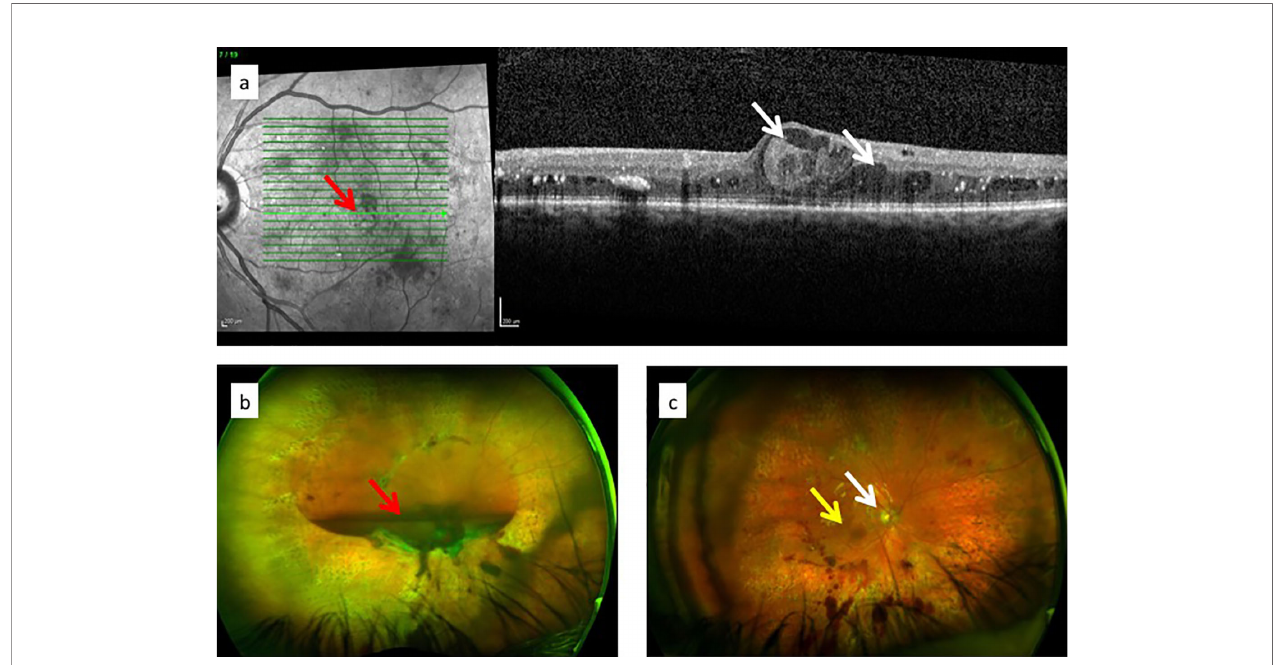
FIGURE 6 | (a) Optical coherence tomography (OCT) images of diabetic macular oedema: fundus image to indicate plane of “ optical section ” (red arrow) through the retina showing macular oedema/retinal cysts (white arrows) in image on the right; (c) ultrawide angle, pre-surgical image of pre-retinal (subhyaloid) haemorrhage in the vitreous cavity obscuring the optic nerve and macula; (c) post-surgical view of same eye in (b) : vitreous cavity is now clear and optic nerve head (white arrow) and macula (yellow arrow) are